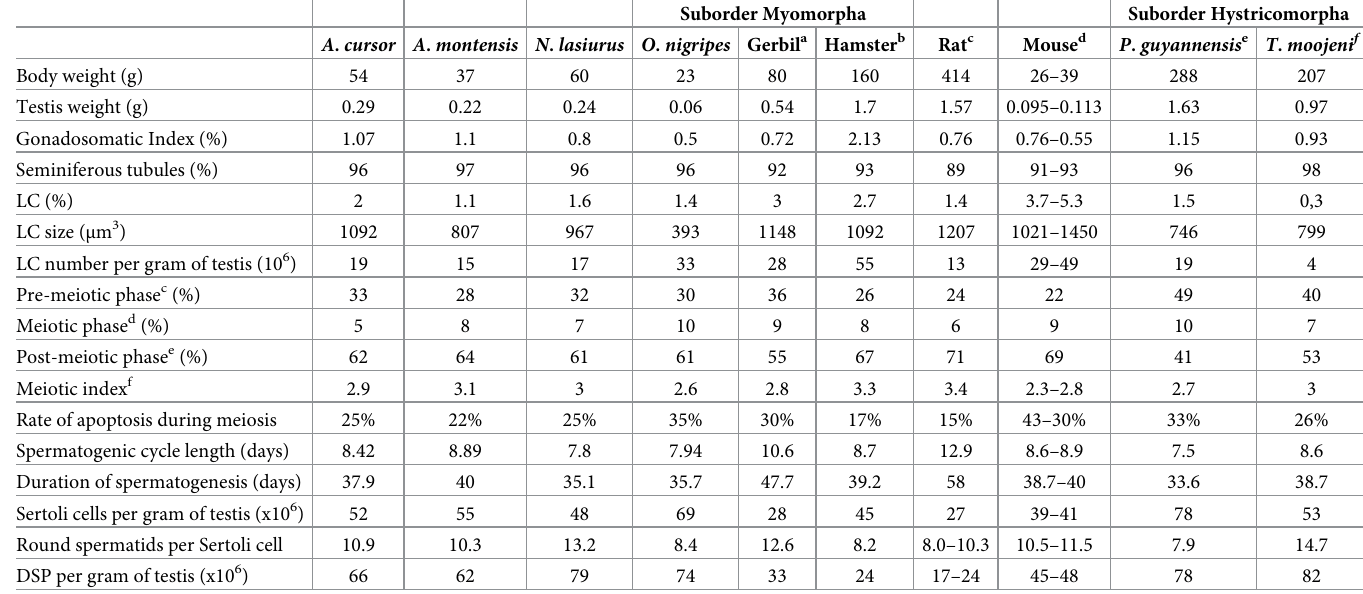
Table 6. Comparative parameters related to biometry, testis stereology and spermatogenic events in well-investigated sexually mature rodent species from the Myo- morpha and Hystricomorpha suborders. Suborder Myomorpha Suborder